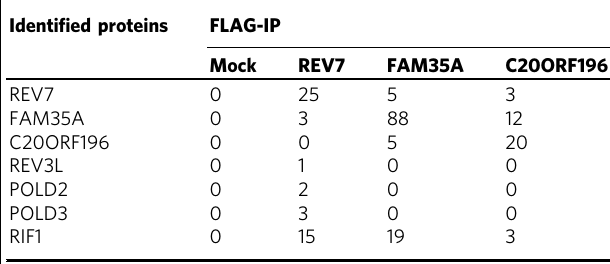
Table 1 Peptide number identi fi ed by mass spectrometry Identi fi ed